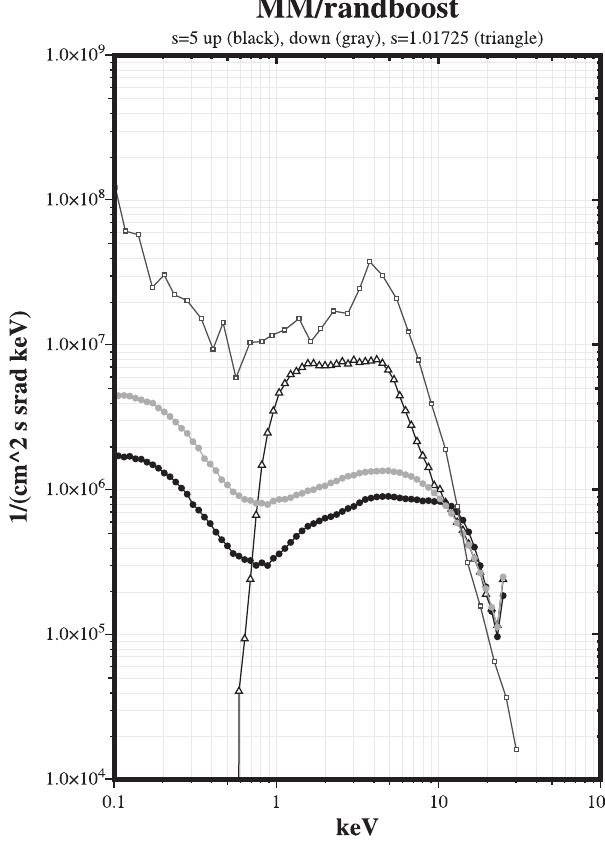
Fig. 17. MM/randboost: same as MMO/randboost but without electric field (only boosts left). The result looks quite unrealistic